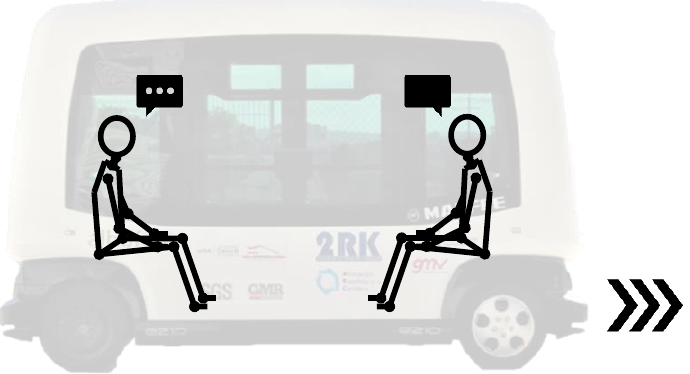
Figure 2. Emergency braking test 1 (BT1) schema.